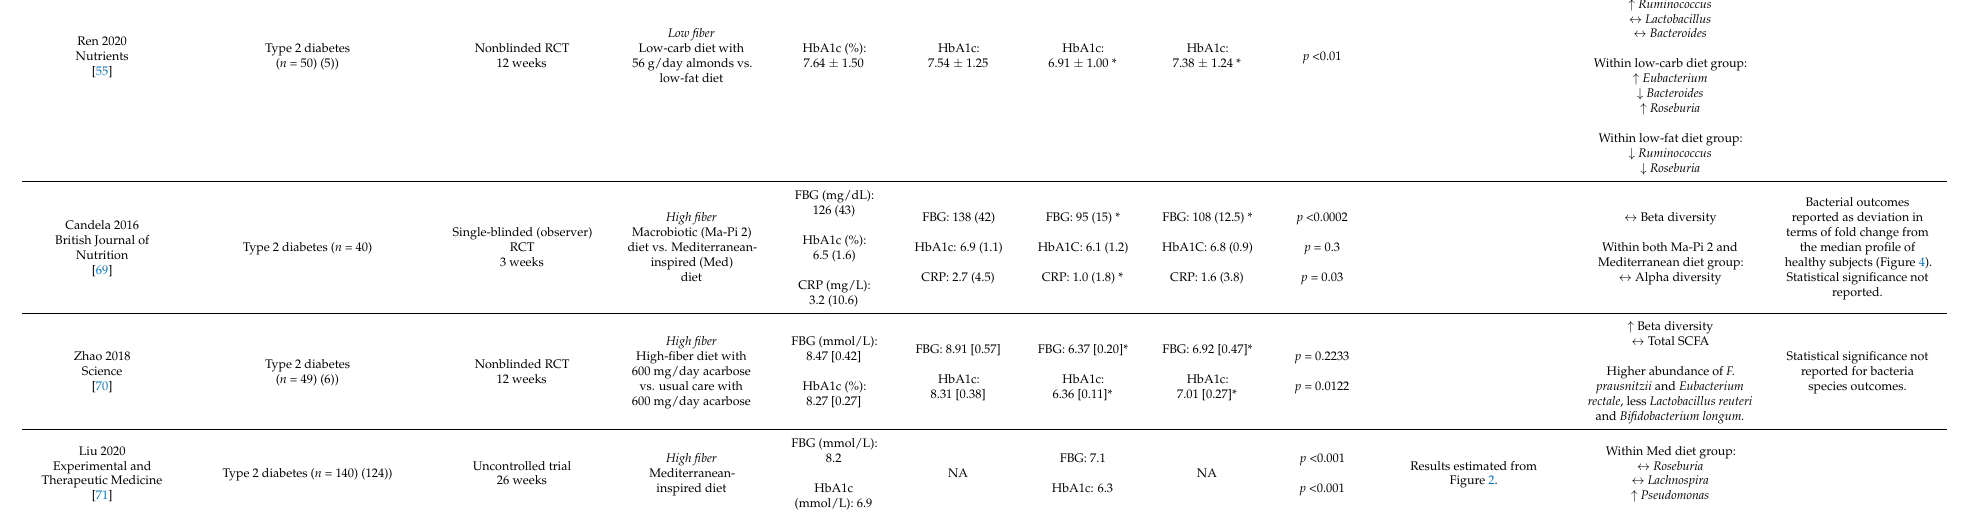
Resultsestimatedfrom